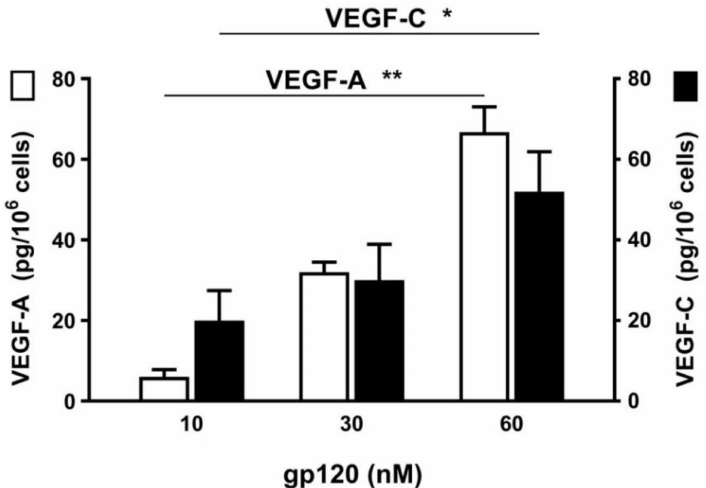
Figure 6. E ff ect of increasing concentrations of HIV gp120 on the release of VEGF-A (open bars) and VEGF-C (black bars) from four di ff erent preparations of HHMCs. HHMCs were incubated (6 h at 37 ◦ C) in the presence of the indicated concentrations of gp120. Each bar shows the mean ± SEM. * p < 0.05; ** p <